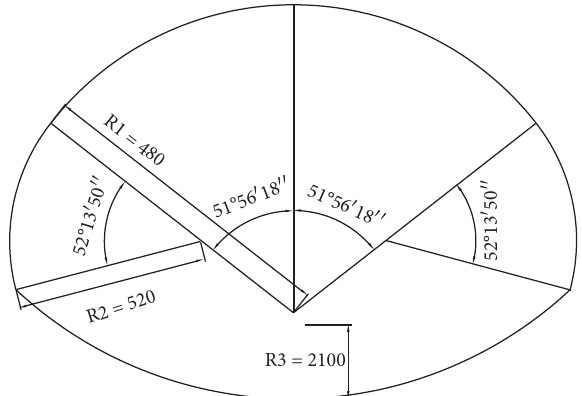
Figure 6: Section of the Yu Liao Tunnel.